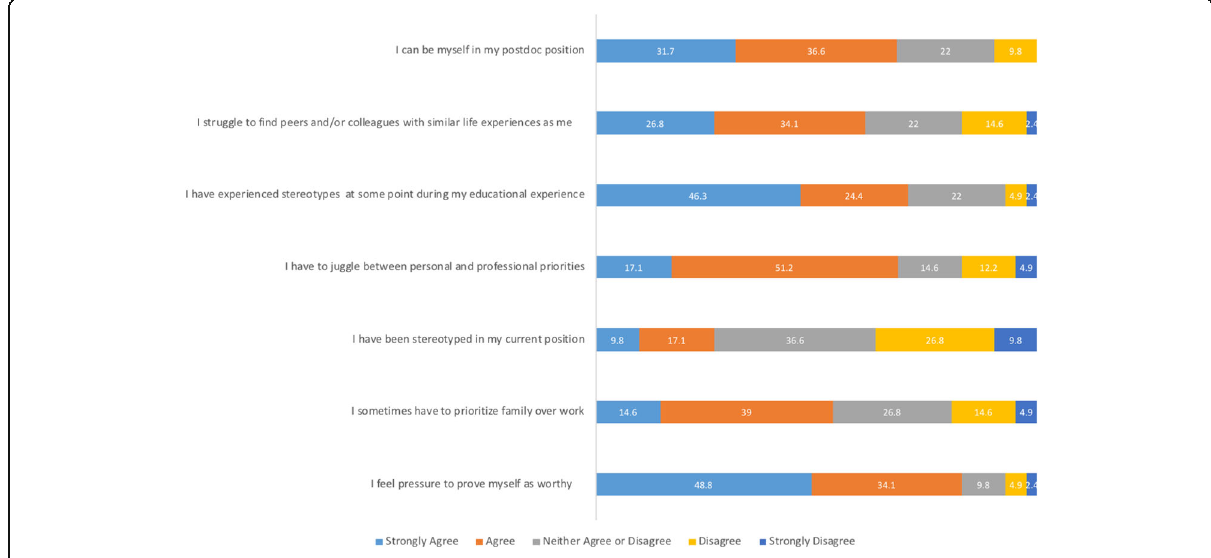
Fig. 6 Postdocs ’ experiences in their